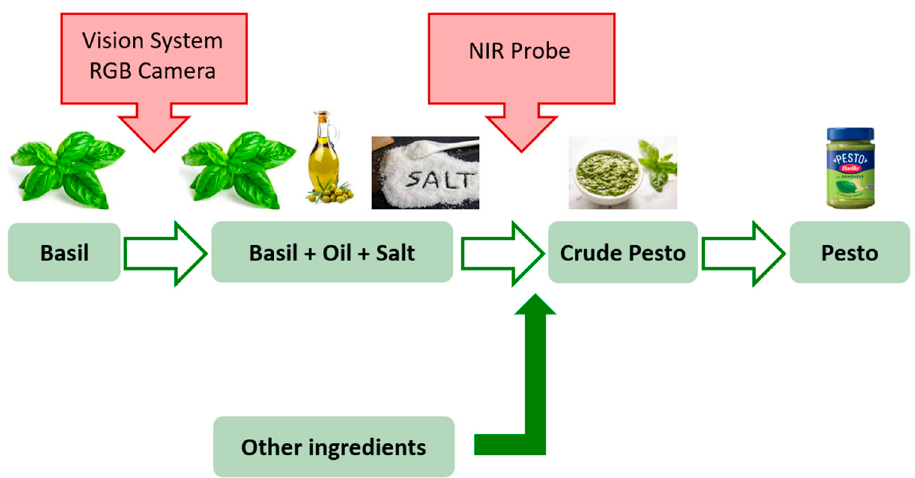
Figure 1. Schematic representation of pesto sauce production process.